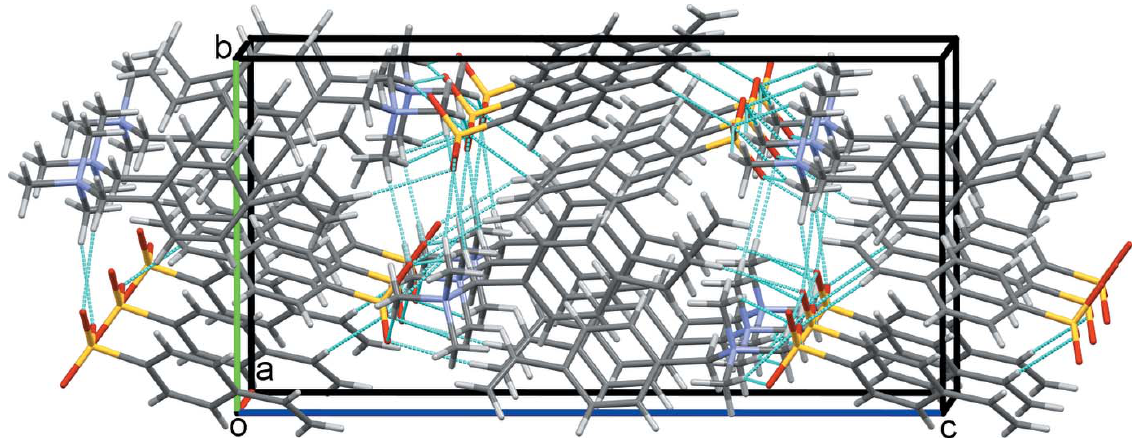
Figure 6 Overall packing for (I) viewed along the a -axis direction.